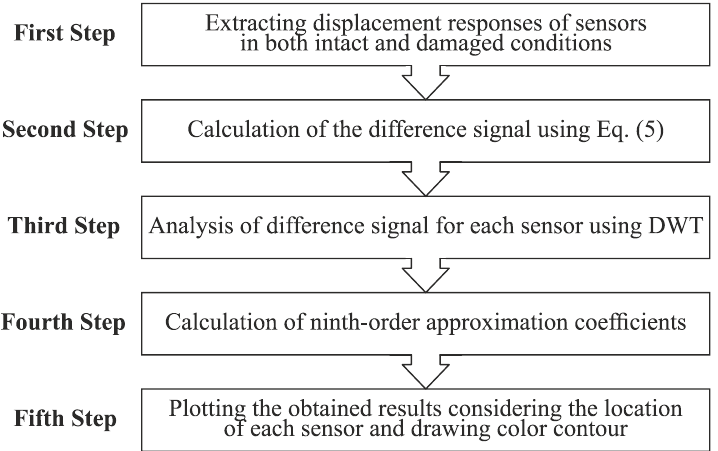
Fig. 2 Flowchart of the algorithm used in bridge deck damage